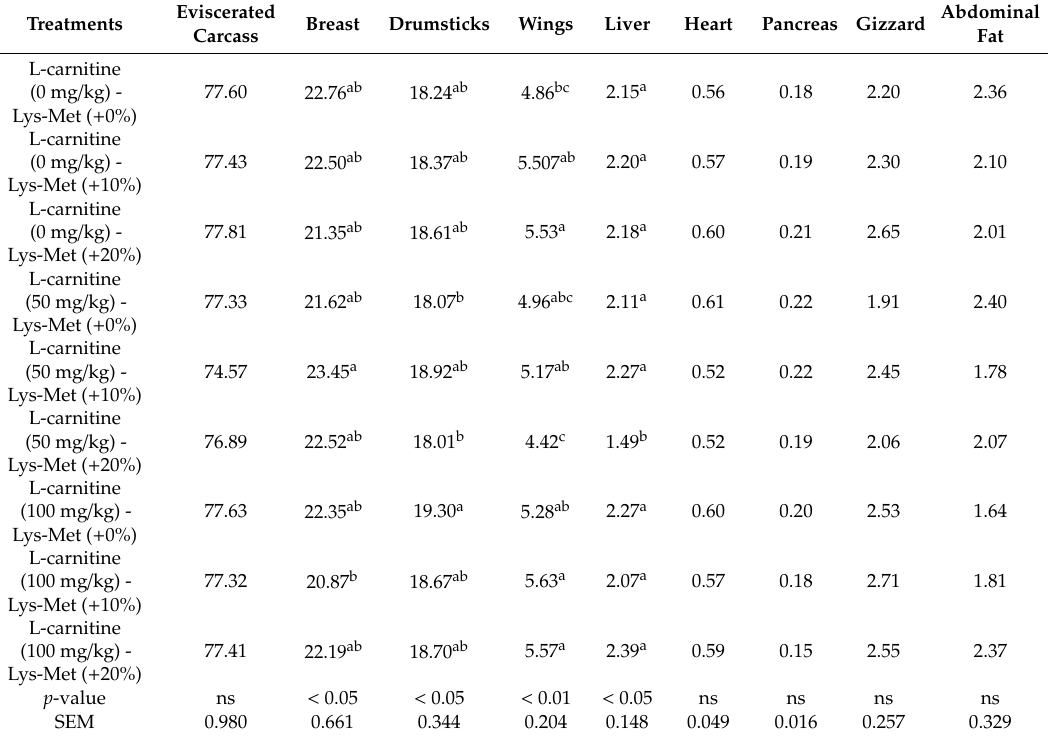
Table 6. Carcass traits (%) of broilers fed di ff erent levels of L-carnitine and lysine-methionine (Lys-Met).